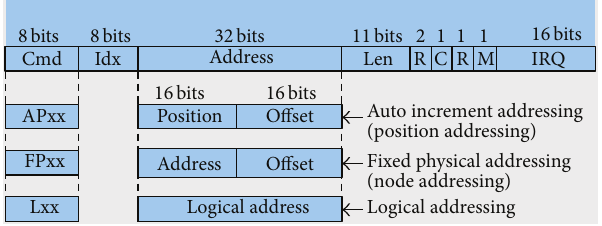
Figure 13: Address Field (slide 34 of